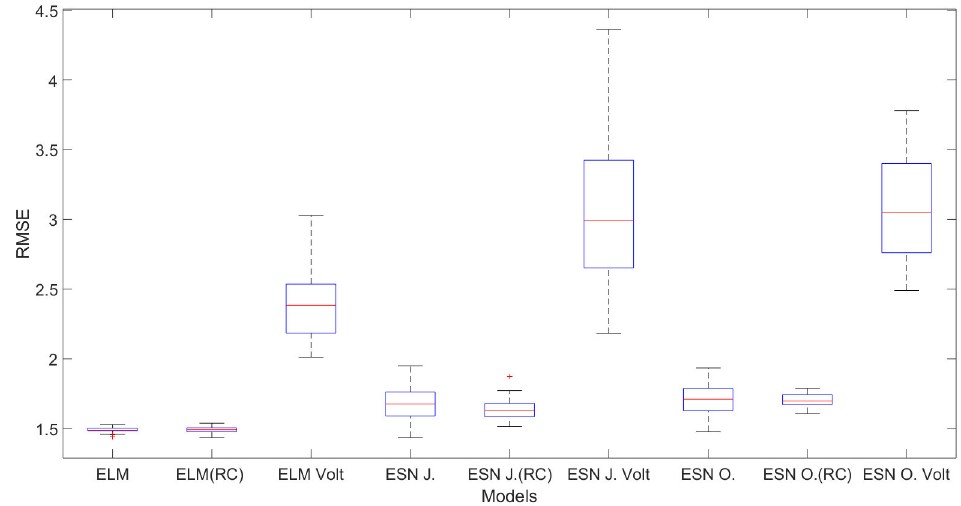
Figure 4. Boxplot graphic regarding the RMSE values for Cubatão-Lag 2.